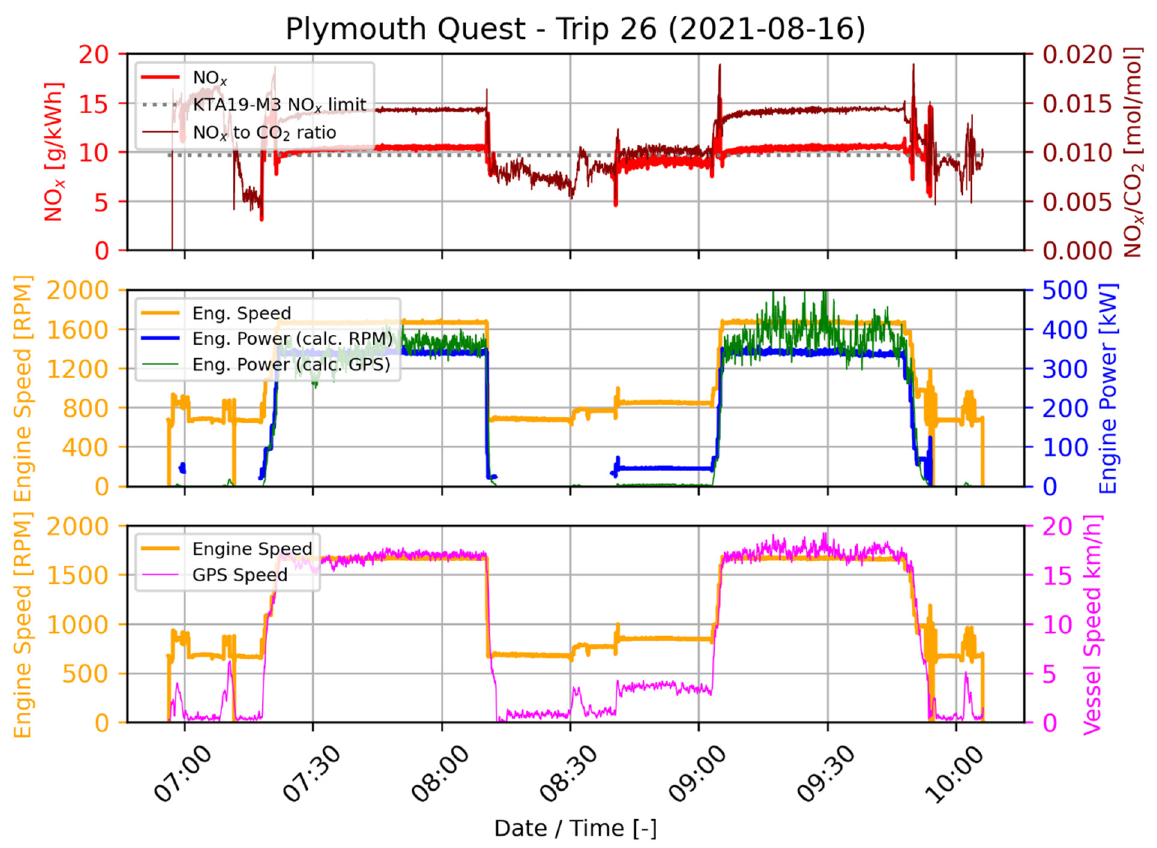
Figure 8. Emission data and ship parameters from RV Plymouth Quest (Trip 26).